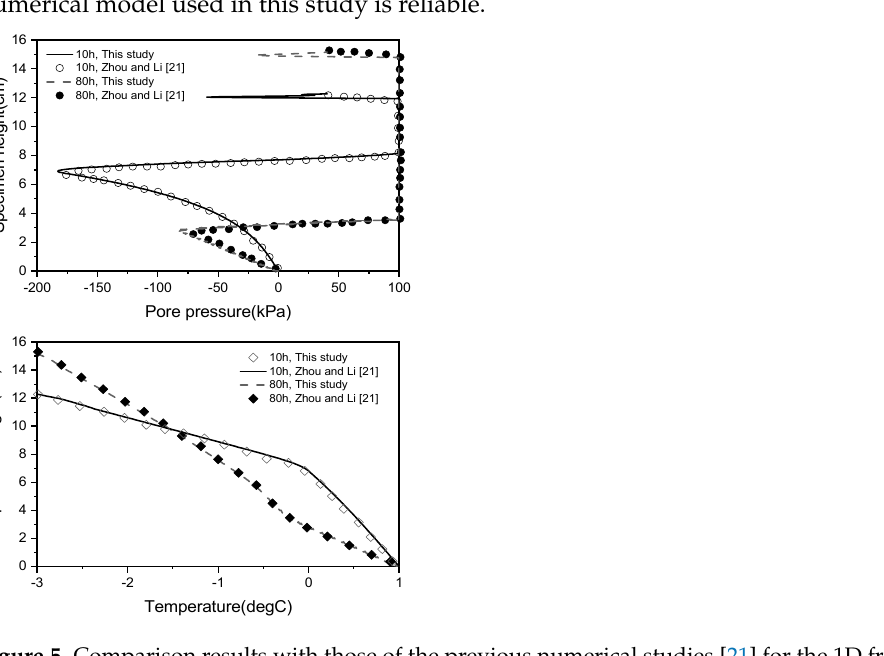
Figure 5. Comparison results with those of the previous numerical studies [21] for the 1D freezing.